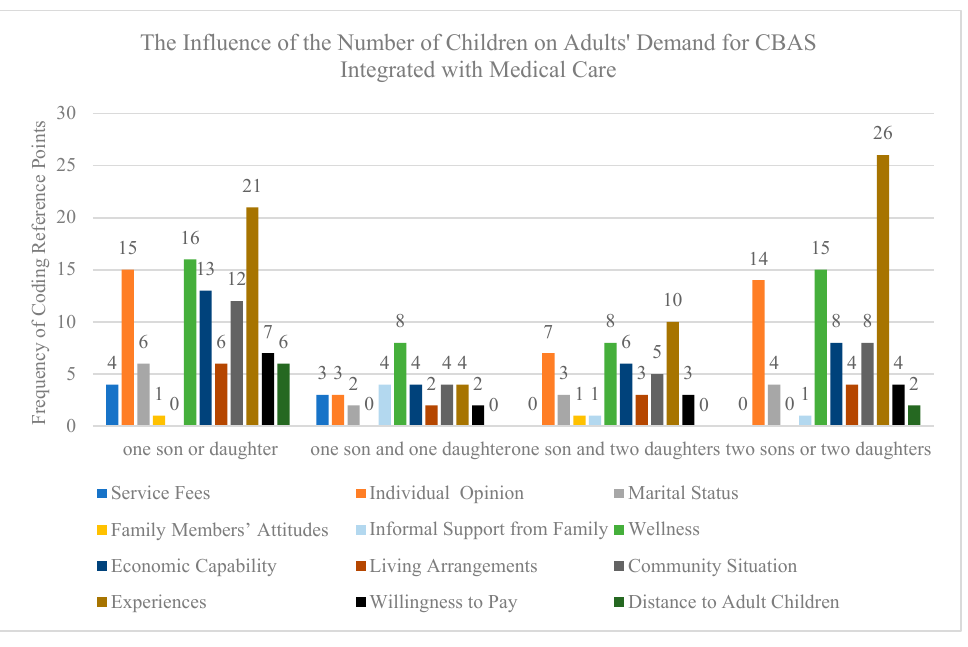
Figure A3. Theoretical model of the factors influencing the demand for CBAS integrated with medical care. References 1.